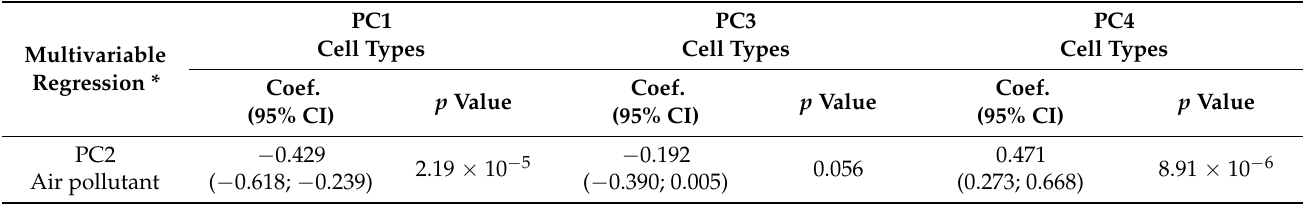
Table 5. Multivariable regression model of PCs of air pollutants previously associated with PCs of cord blood cell types in an univariable regression model. After Bonferroni correction, significance was considered when p < 0.016.